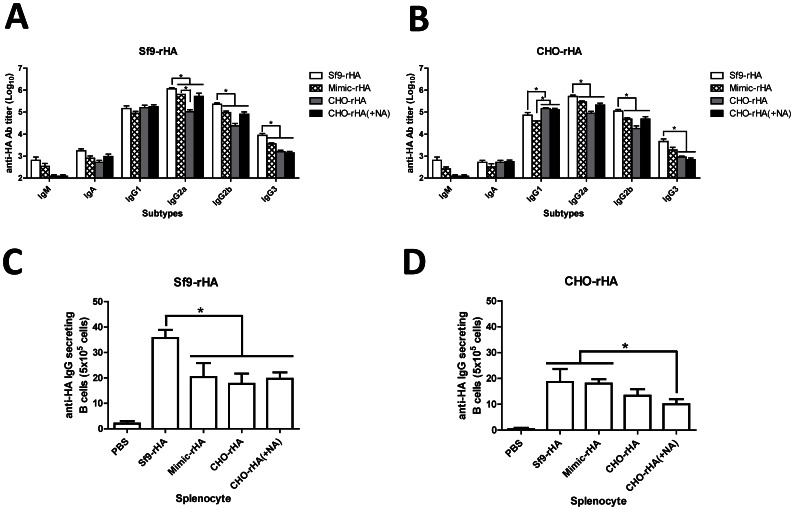
Antibody isotypes/subtypes and antibody-secreting B cells.The antibody isotypes of IgM and IgA and the IgG1, IgG2a, IgG2b and IgG3 subtypes in sera were analyzed using ELISA plates coated with (A) Sf9-rHA or (B) CHO-rHA. Mouse splenocytes were collected 3 wk following second inoculations, and then reacted with (C) Sf9-rHA or (D) CHO-rHA to measure the numbers of antibody-secreting B cells in spleens; ELISPOT assays were performed using HRP-conjugated anti-mouse IgG antibodies. Data represent mean ± standard deviation; results were analyzed using one-way ANOVAs with Tukey's tests, with statistical significance at p<0.05 as asterisks indicated.